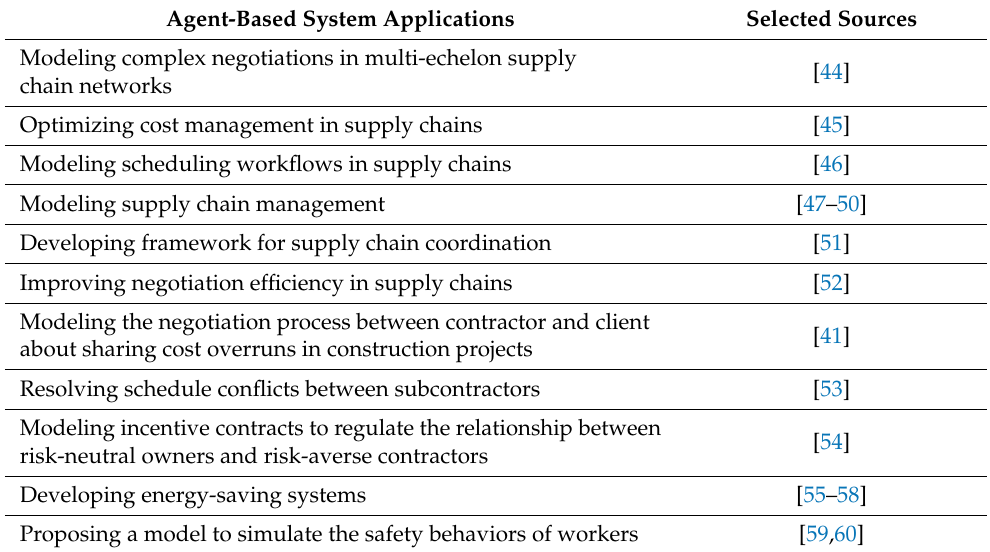
Table 2. Research about Multi-Agent